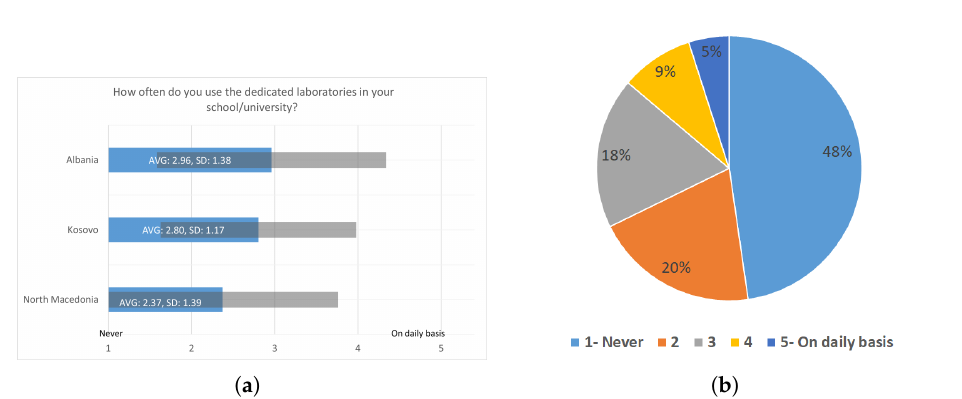
Figure 10. ( a ) Knowledge of virtual and digital technologies. ( b ) Training with AI or VR technologies.